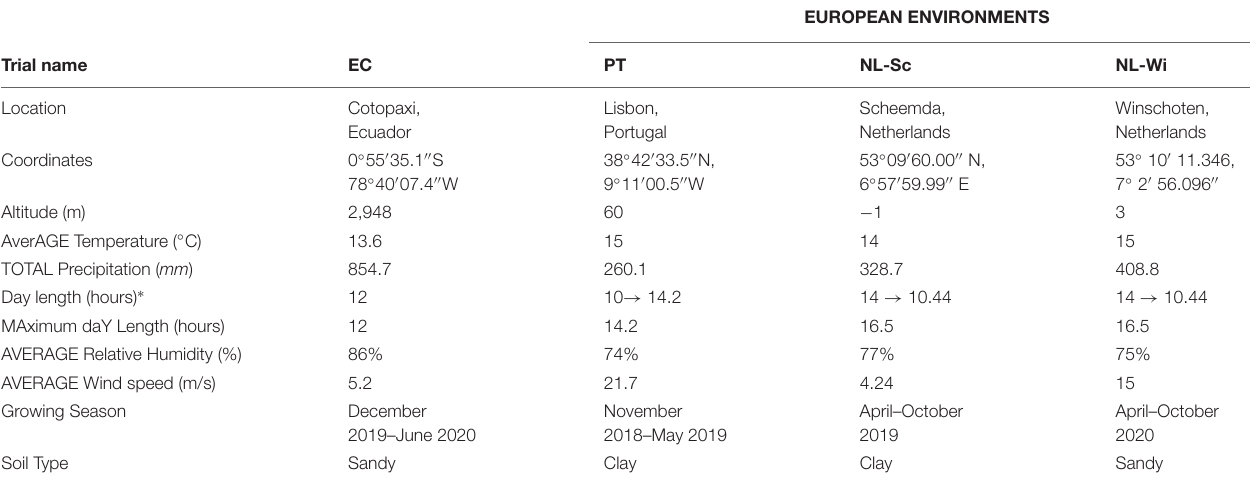
FIGURE 1 | Geographic distribution of the 225 Lupinus mutabilis accessions included in the panel under study. Dots on the map indicate the provenience of the accessions. For the breeding material, dots indicate the institutes developing and providing the lines for our collection (ISA, Portugal; JKI, Germany; Byelorussian Agricultural Academy, Belarus). For the accessions from South America (donated by INIAP), dots indicate the provenience of landraces, varieties, and wild material collected along the Andean region, when these data were available. Maps were generated using mapview package in R (v. 2.11.0, Appelhans et al., 2022). TABLE 1 | Environmental characteristics of the four field trial locations during the respective growing season. EUROPEAN